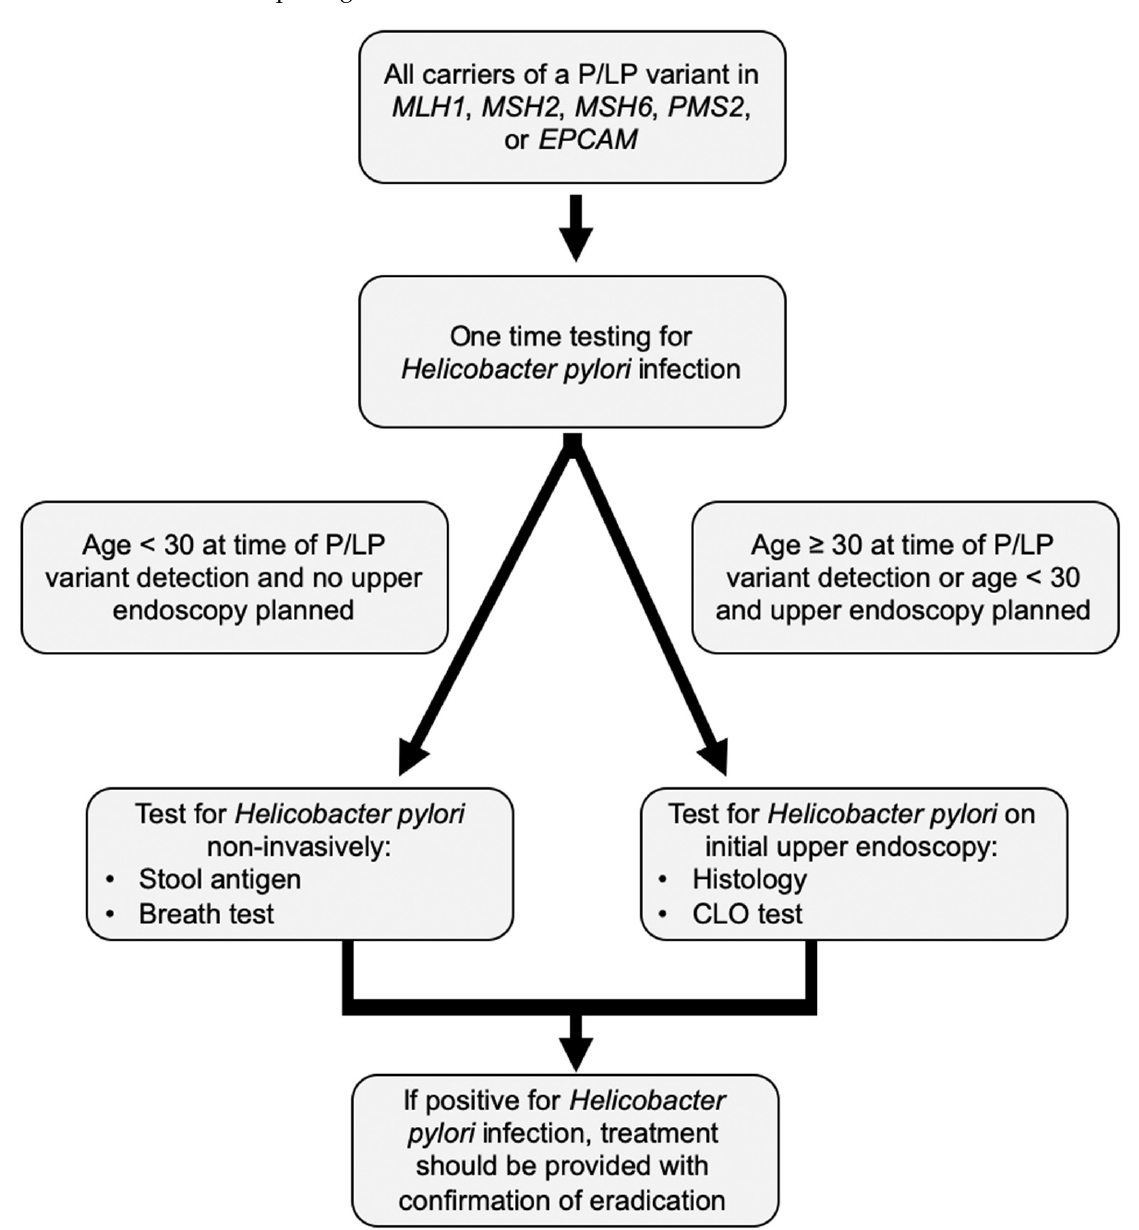
Figure 1. Authors’ approach to Helicobacter pylori screening in Lynch syndrome. P/LP variant: Pathogenic/Likely pathogenic variant; CLO test: Campylobacter-like organism test (also known as the Rapid Urease Test).